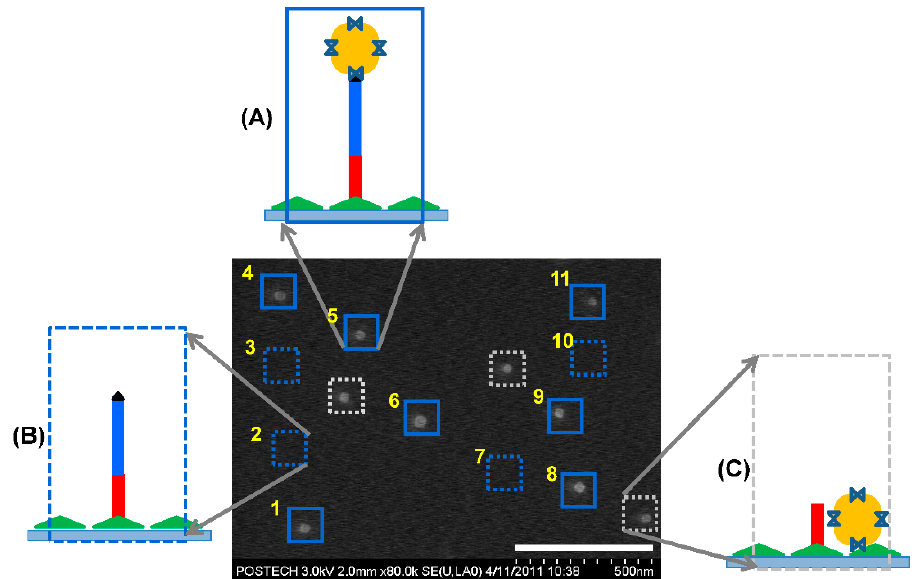
Figure 3. Evaluation of the DNA-AuNP complexes. ( A ) A single streptavidin-coated AuNP was imaged in the area surrounding a point where a single 71mer DNA with a terminal biotin moiety was covalently immobilized. The position of the DNA-AuNP complexes is indicated by the blue-lined square. ( B ) No AuNP was detected at a point where a single 71mer DNA was positioned. The position of a single DNA without AuNP is indicated by the blue-dotted square. ( C ) A AuNP was detected outside the DNA positioning map. The position of the AuNPs non-specifically bound to the silicon substrate is indicated by the gray-dotted square.